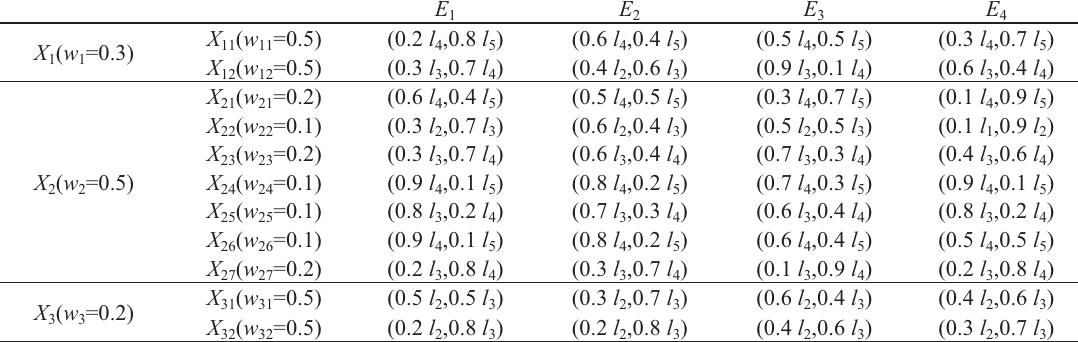
Table 2. The group decision matrix R 2 for Hubin commerce & tourism district using PTLVs